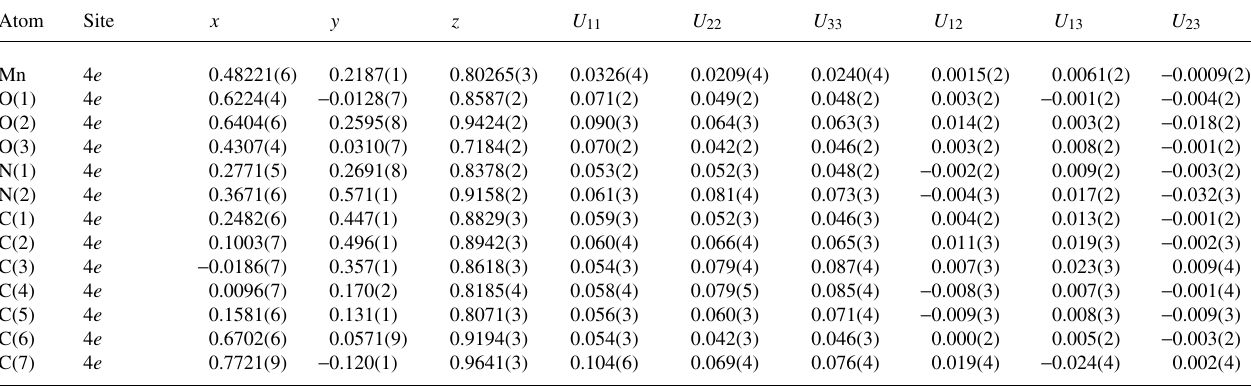
Table 3. Atomic coordinates and displacement parameters (in Å 2 )